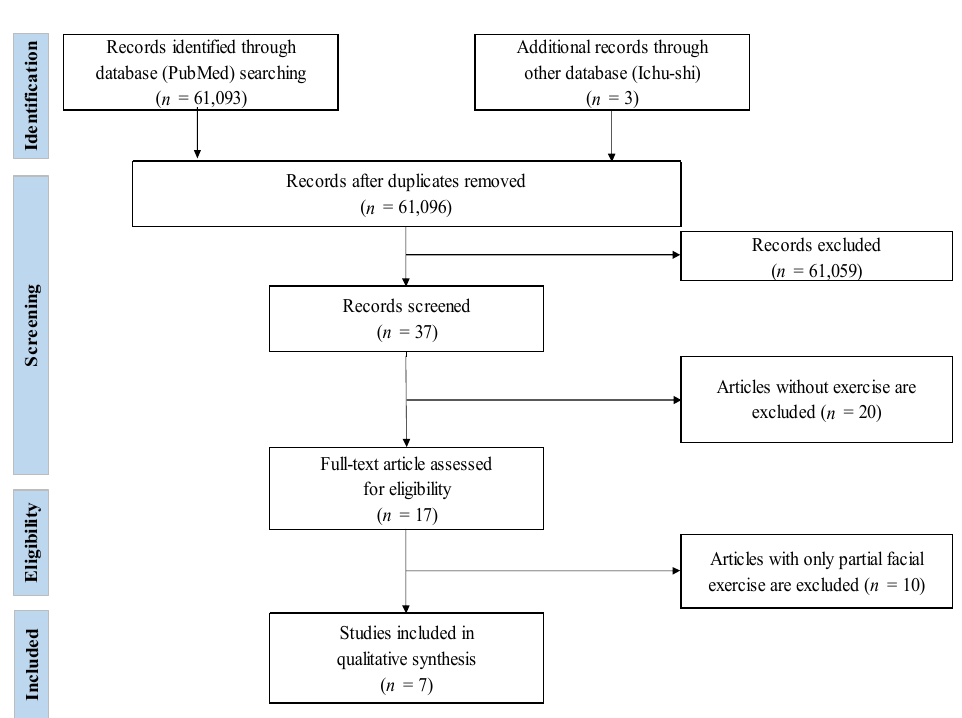
Figure 1. PRISMA flow diagram.